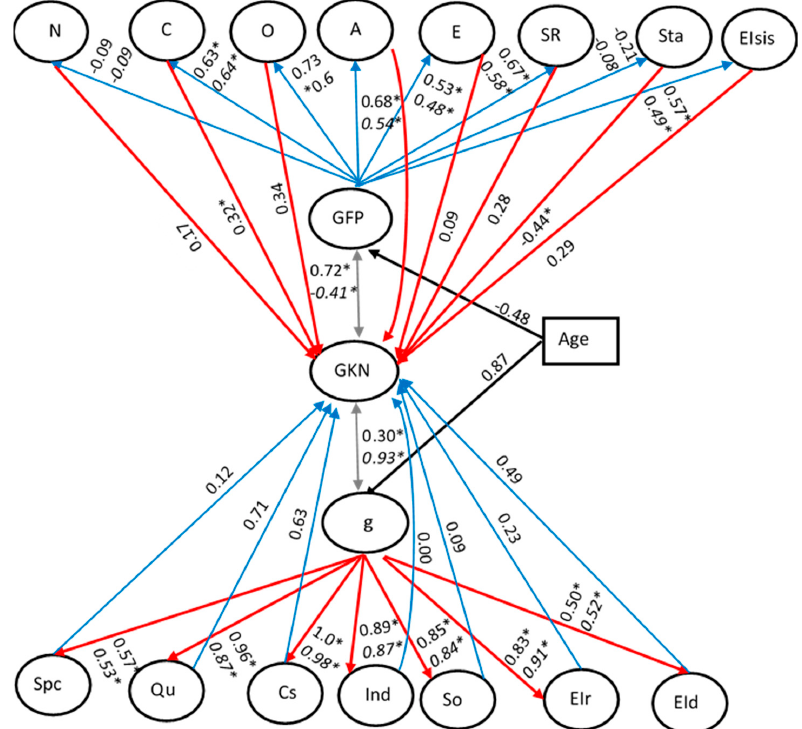
Figure 9. The “cognition −→ personality” (blue arrows) and “personality −→ cognition” (red arrows) mediation models showing how cognizance mediates between cognition and personality. Note. The first and second number pair come from the “cognition −→ personality” and the “personality −→ cognition” model, respectively. The grey arrows connecting g, cognizance (COGN), and the GFP should be read as either pointing upwards (the “cognition −→ personality” model, first number of each pair) or downwards (the “personality −→ cognition” model, second number of each pair). Symbols Spc, Qu, Cs, and Ind stand for spatial, quantitative, causal, and inductive reasoning; symbols EIr and EId stand for the ability to understand, and specify emotions, respectively; the symbols N, C, O, A, and E stand for the Big Five Factors; the symbols SR, Sta, and EIsis stand for self-awareness about emotions, emotional stability, and recognition and management of emotional signals, respectively. Asterisks indicate significant relations (see complete models in Supplementary Materials, Study 3, Models 2 and